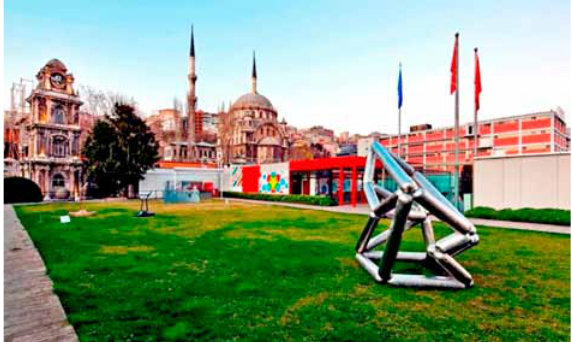
fig. 12. Garden of Istanbul Museum of Modern art (photo by